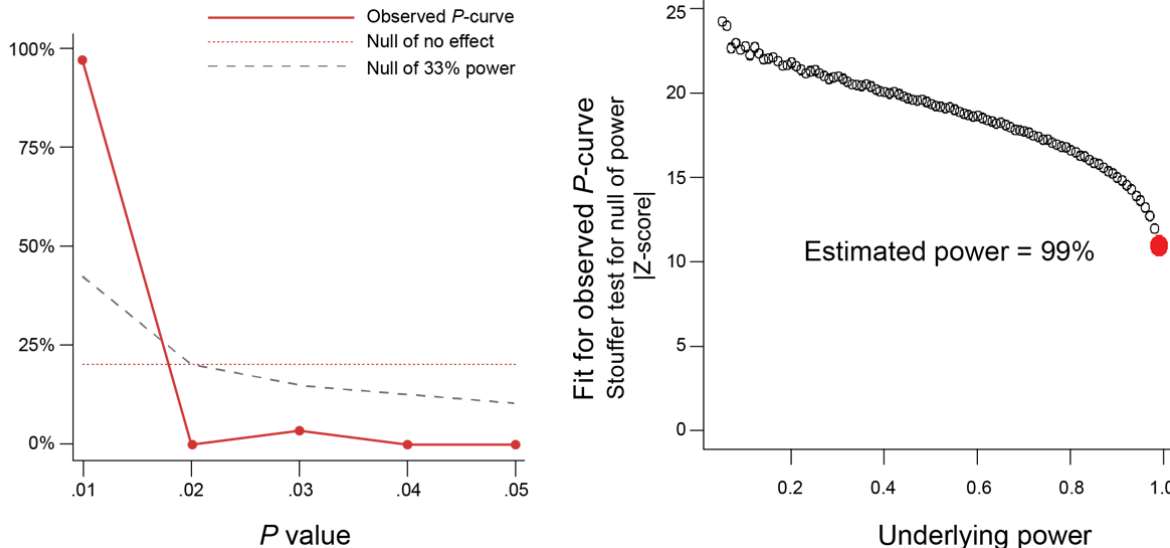
Figure 4. The observed P -curve has an estimated power of 99% (left and right), significant right skewness, P full < .0001, P half < .0001 (left), and no significant flatness, P full > .9999, P half >